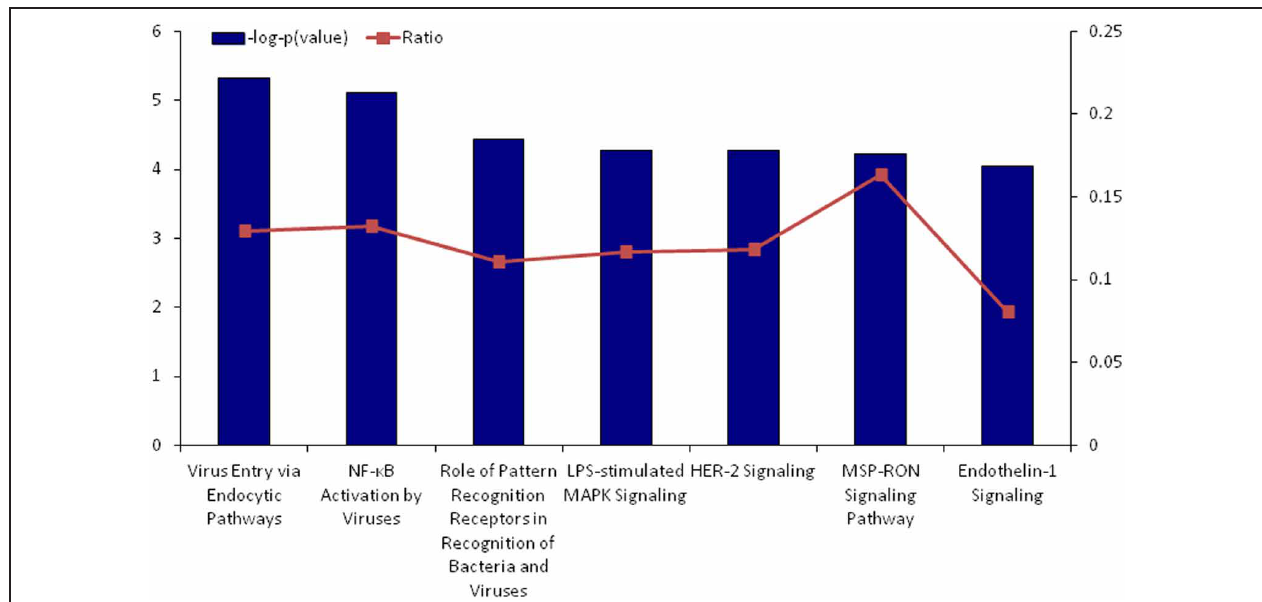
p -value determining the probability that the association is explained by chance alone (blue bars, y-axis). Ratios defining the proportion of upregulating genes from a pathway related to the total number of molecules that make up that particular pathway are also displayed (line graph,